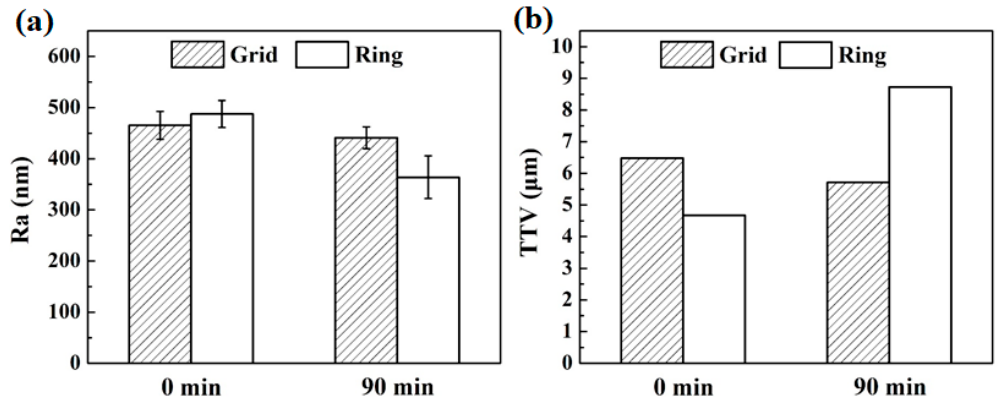
Figure 7. ( a ) Surface roughness and ( b ) total thickness variation (TTV) of original and lapped sapphire substrates by composite plates with sol–gel balls arranged in concentric ring and grid patterns.